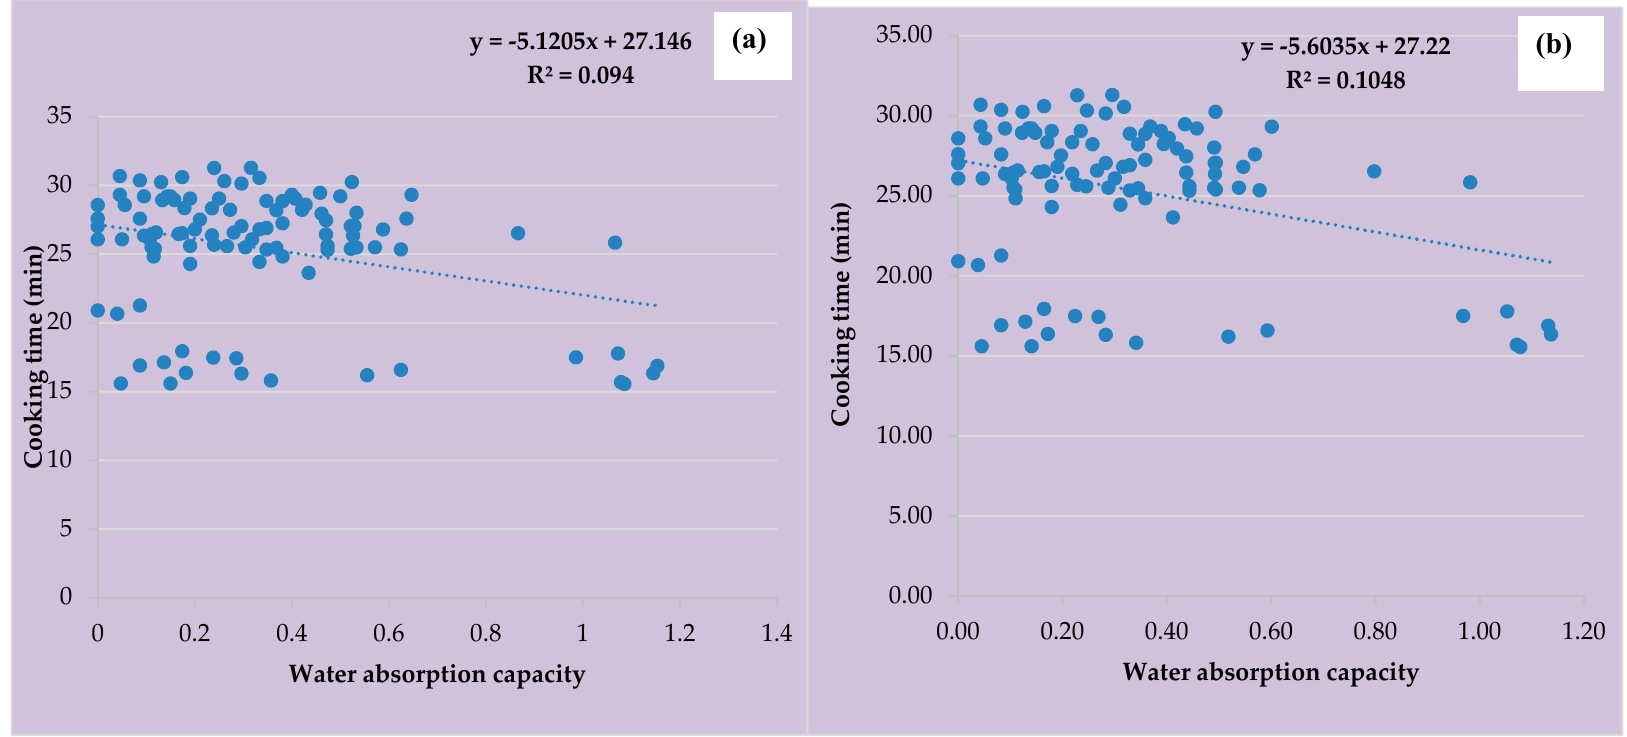
Figure 4. Correlation between water absorption and cooking time for the Vigna vexillata accessions. ( a ) Plotted with data from Site A; ( b ) plotted with data from Site